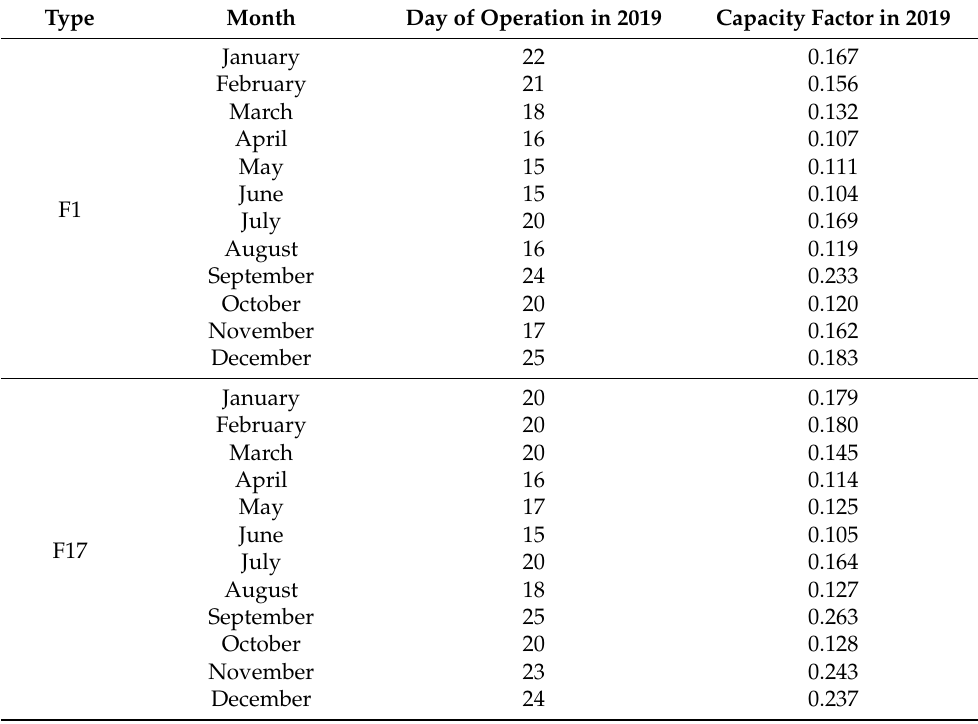
Figure 10. Theoretical capacity factor per month over 3 years. Table 4. Actual operating days and capacity factor of wind turbines.